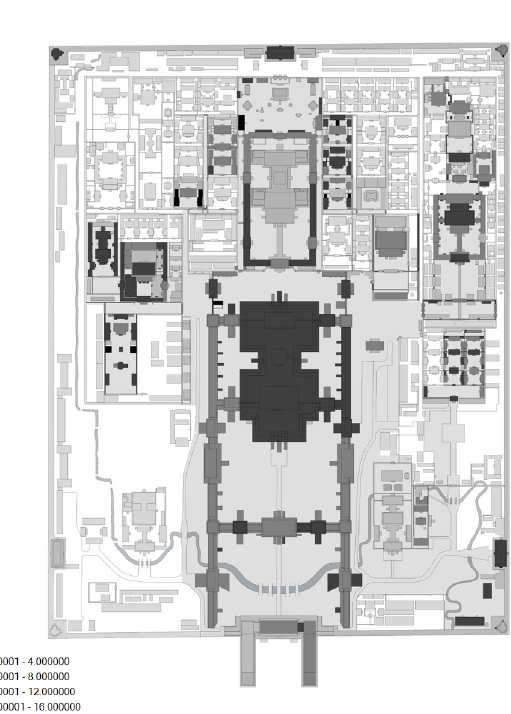
Figure 8. The replacement-repair condition of